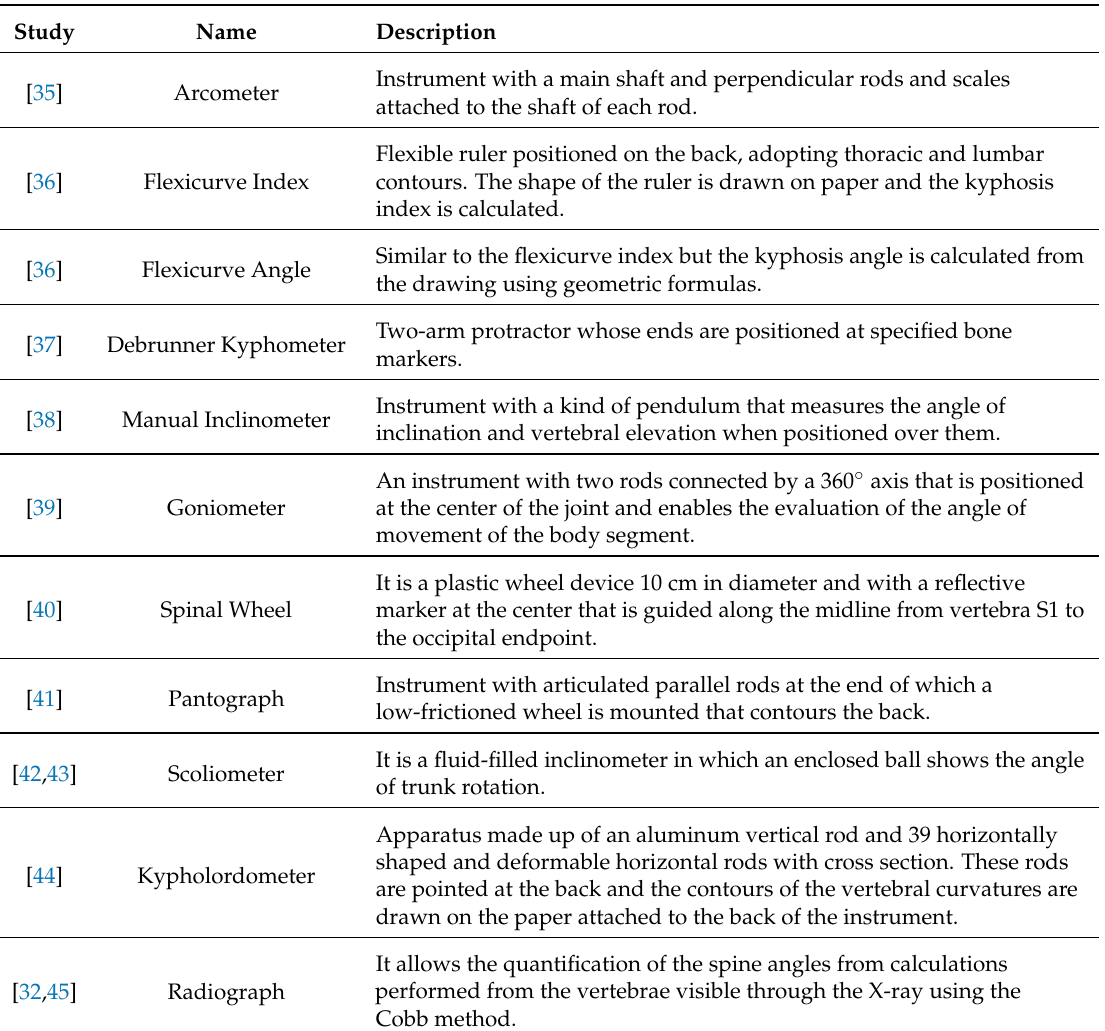
Table 1. Summary of manual assessment tools for human postural deviations.